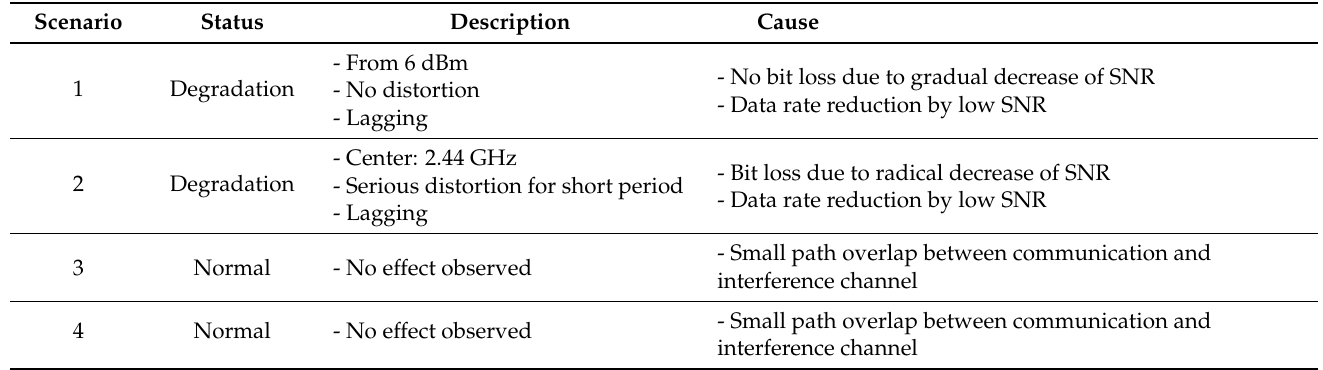
Table 9. Experiment results of low power IEMI on camera module using digital communication